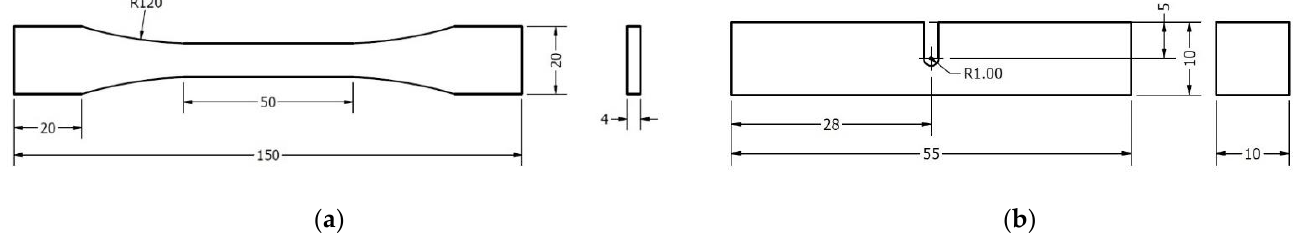
Figure 4. Testing tubes: ( a ) tensile testing tube ISO 527 type 1B; ( b ) Charpy testing tube.